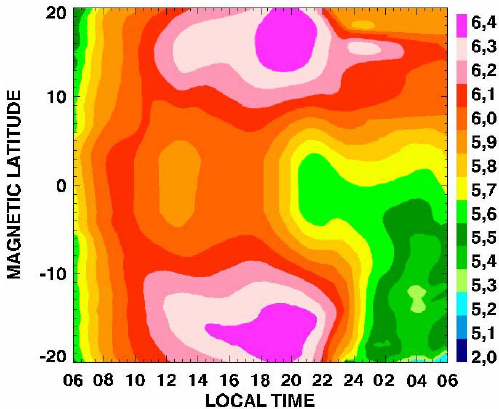
Fig. 5. Ionospheric electron density peak ( n m ) as a function of mag- netic latitude and local time generated by the LION model for av- erage solar conditions in the Brazilian longitudinal region, during